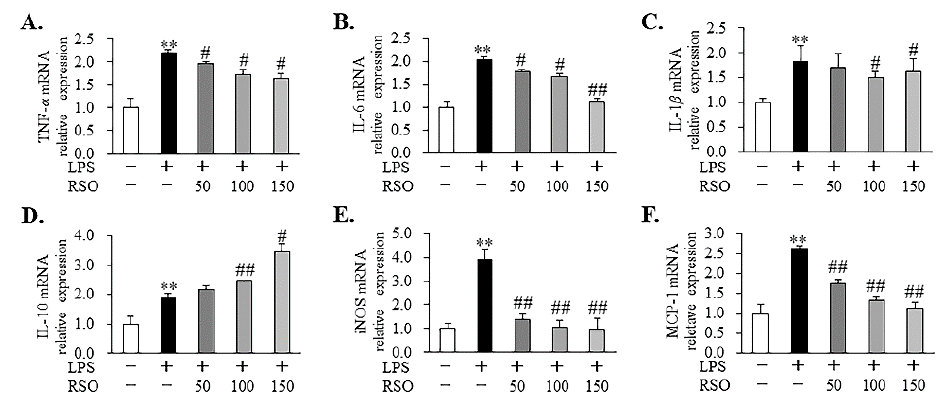
Figure 6. Effect of RSO on inflammatory-related gene relative expression of LPS-induced RAW 264.7 cells. Relative mRNA expression of TNF- α ( A ), IL-6 ( B ), IL-1 β ( C ), IL-10 ( D ), iNOS ( E ), and MCP-1 ( F ) genes normalized to β -actin and expressed as fold change of the control group, n = 3. ** p < 0.01 vs control group; # p < 0.05, ## p < 0.01 vs LPS-induced group.